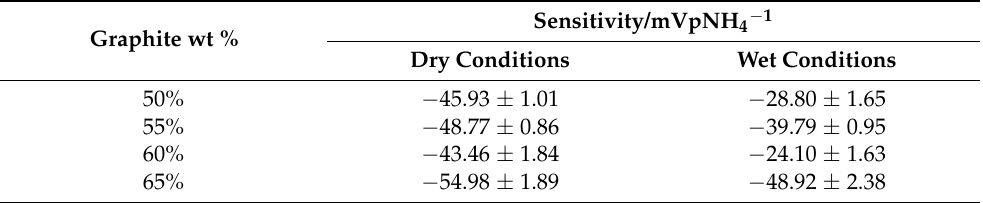
Figure 5. Dynamic response diagrams of the graphite disk electrode modified with a transducer layer of different wt % graphite particles embedded in PVB and coated with a layer of ammonium-selective membrane. Measurements were performed in NH 4 Cl solution, c (NH 4 ) = 10 − 1 M − 10 − 6 M, after storage of the sensor under dry ( a ) and wet ( b ) conditions. Lines represent the linear fit of the data points, over the determined linear range. Table 1. Slopes of the calibration curves, after storage under dry and wet conditions, for the disk potentiometric sensors prepared with different graphite